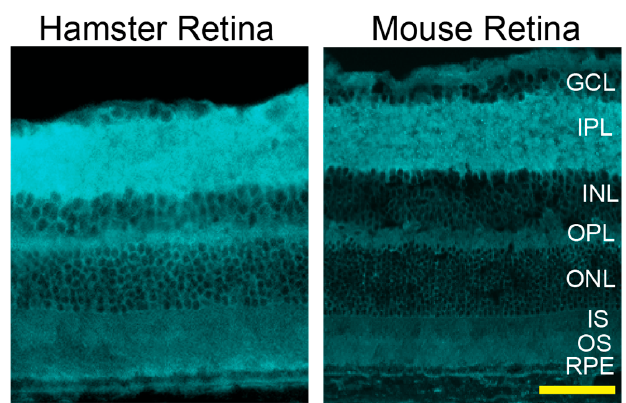
Figure 9. Retinal distribution of unesterified cholesterol in hamsters and mice (C57BL/6J). A fluorescent antibiotic filipin was used for staining of retinal cross sections (cyan). Both images are representative (3 females and 2 males for hamsters and 4 females and 2 males for mice). The retinal layer labeling is as described in Figures 1 and 2. Scale bar = 50 µm.